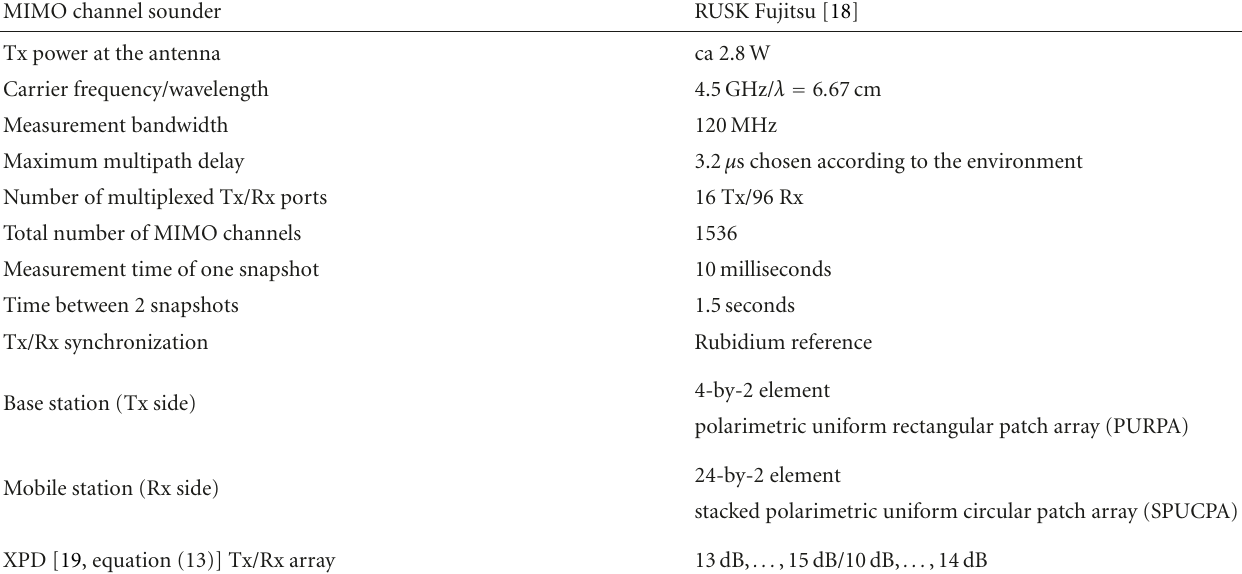
Table 1: Measurement